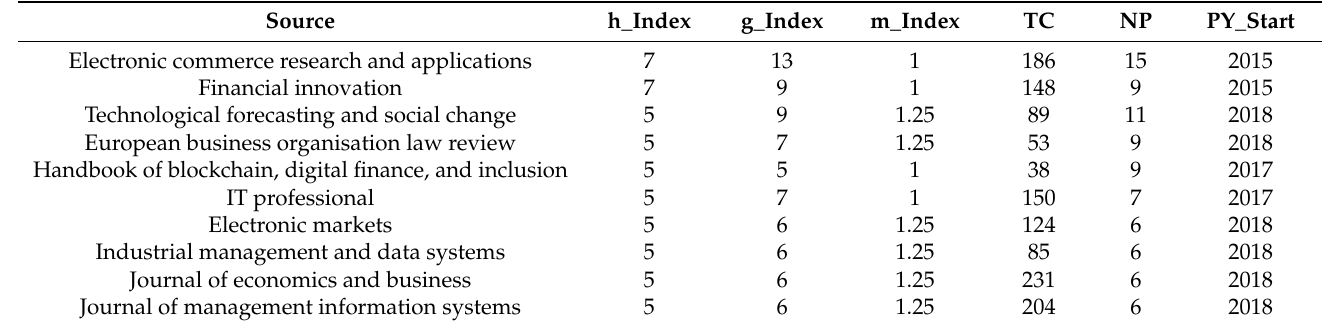
Table 2. Top ten sources with impact.